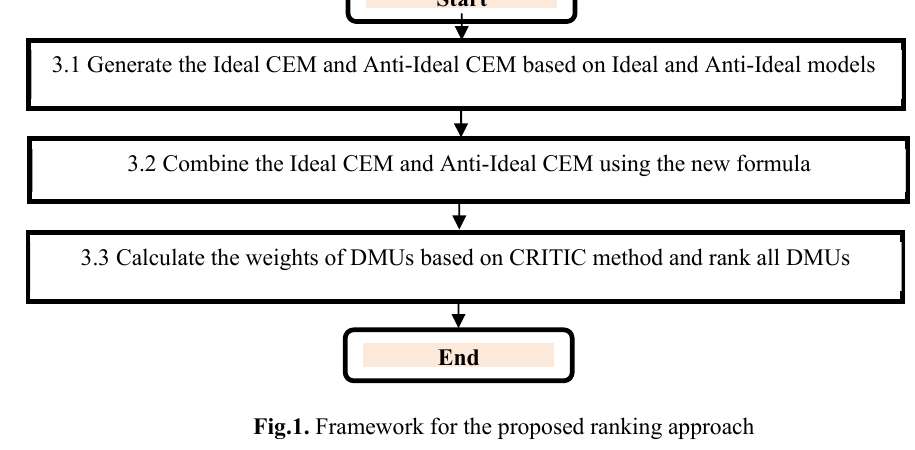
Fig.1. Framework for the proposed ranking